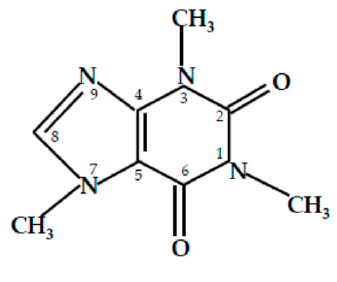
Figure 1. Scheme of caffeine.